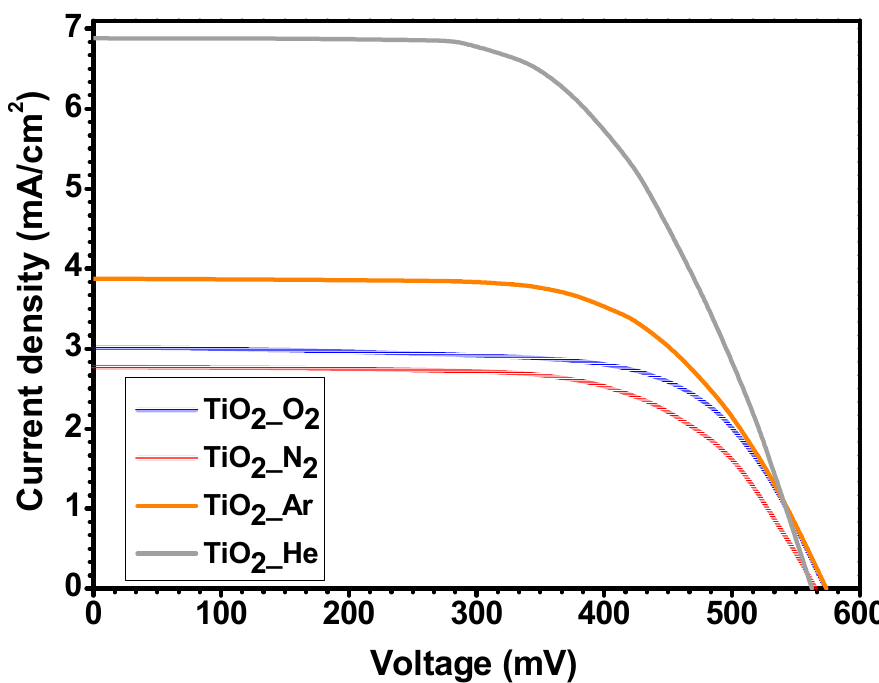
Figure 5. Current–voltage curves for typical dye-sensitized solar cells fabricated using photoelec- trodes with various coatings: TiO 2 _O 2 ( blue line ); TiO 2 _N 2 ( red line ); TiO 2 _Ar ( orange line ); and TiO 2 _He ( grey line ). The measurements were carried out under standard AM 1.5G illumination conditions. Table 3. Electro-optical parameters: short-circuit current ( I SC ); open-circuit voltage ( V OC ); short- circuit current density ( J SC ); maximum power ( P max ); fill factor ( FF ); and photovoltaic conversion efficiency ( η ) of typical DSSCs measured under standard illumination